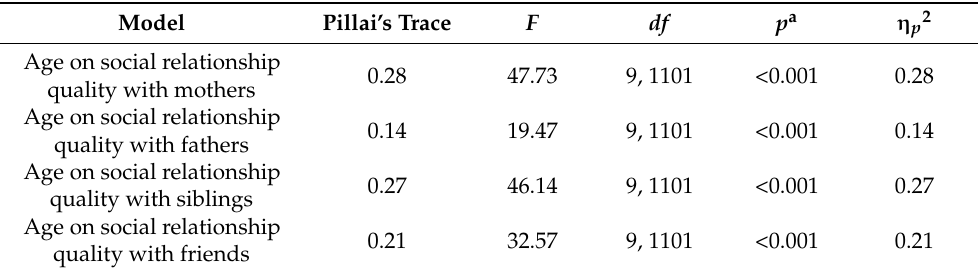
Table 2. Multivariate analyses of variance (MANOVAs) testing the effects of age on children’s social relationship quality with mothers, fathers, siblings, and friends ( N = 1110).